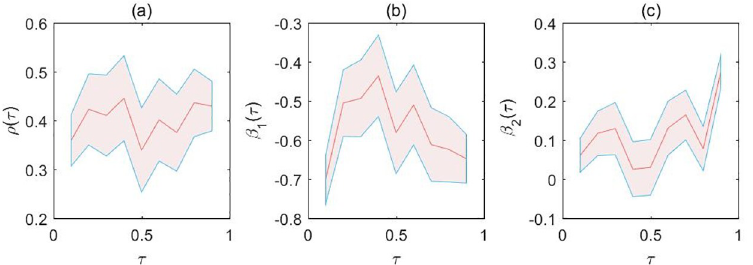
Fig 2. Quantile effects of the spatial correlation coefficient, the log average retail price of a pack of cigarettes and the log disposable income. The areas represent 95% point-wise confidence intervals.